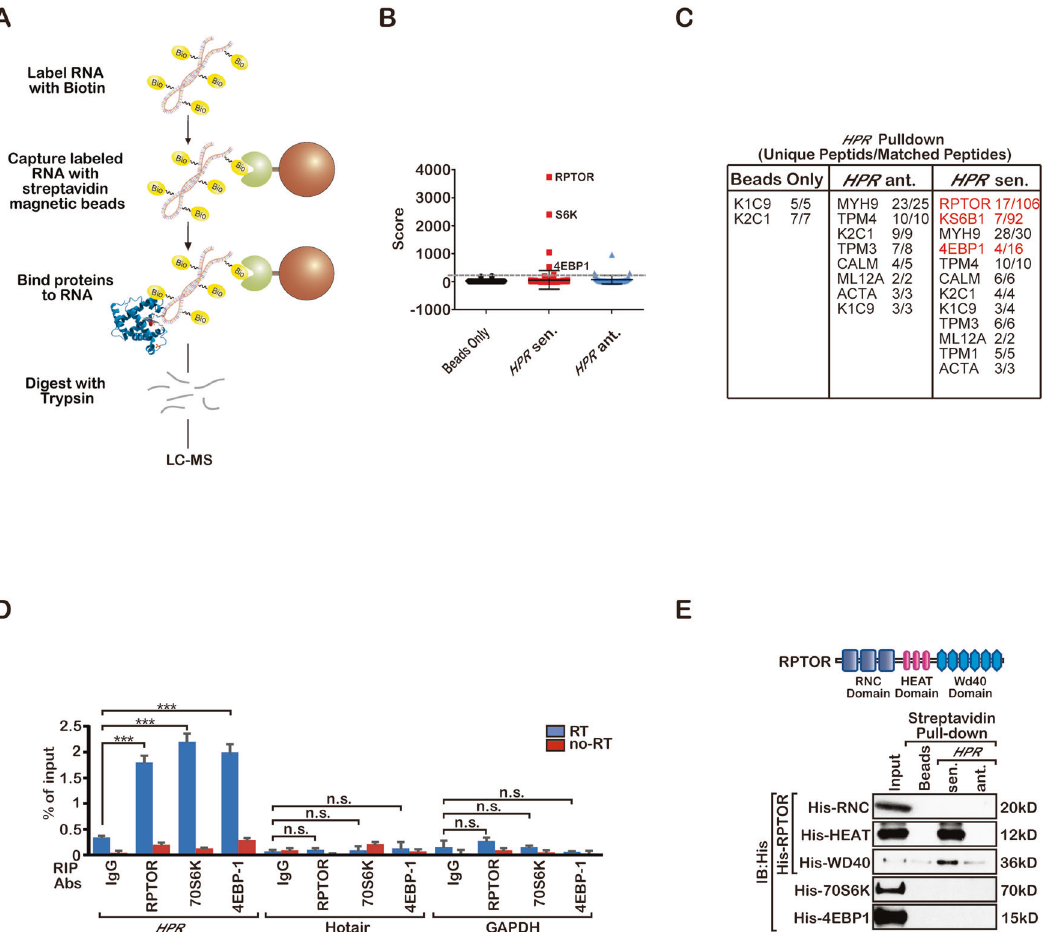
Fig. 5 HPR interacts with Raptor. a Graphic illustration of the RNA pulldown assay. b , c List of the top HPR -associated proteins identi fi ed by RNA pulldown and MS analysis in MDA-MB-231 cells. d RIP assay detection of the interaction of HPR with the indicated proteins (*** P < 0.001). The results are the mean ± s.e.m. of n = 3 independent experiments. P values were determined by one-way ANOVA. e In vitro RNA-protein binding assay detection of HPR interactions with the indicated proteins. Three independent experiments were performed and yielded similar